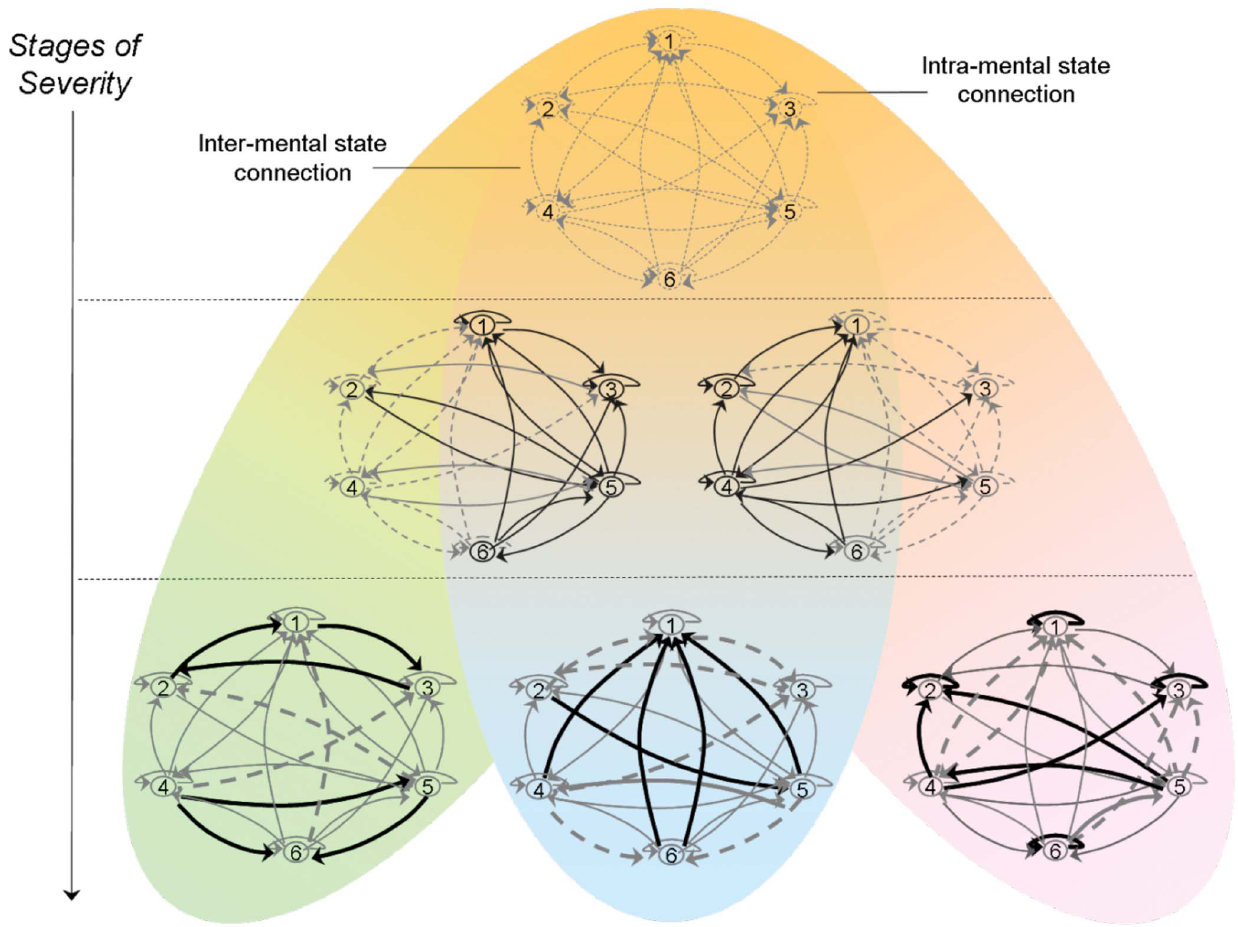
Figure 1. Visual representation of dynamics between mental states with increasing levels of psychopathological severity. Depicted is a hypothesized circuit between 6 mental states across different stages of severity. The connections represent the impact of one mental state at time point t -1 on another mental state at time-point t . The impact of a mental state on itself from t -1 to t is the intra-mental state connection. In the earliest stage, inter and intra-mental state connections are uniformly weak (top; dotted lines). In the next stage, inter- and intra-mental state connections not only get stronger (middle; solid lines), but there are also more differences between persons with regard to which connections get stronger (person on the left strongest connections on the right side of the circuit, person on the right strongest connections on the left side of the circuit), i.e. there is more profiling. In the most severe stage of psychopathology, mental state connections are growing even stronger (bottom; bold/ dotted lines) and more variable across persons. The increased variability in connection strength can be quantified by the random effect from the multilevel random regression model. Thus, staging is represented in this figure by increasing severity of psychopathology, reflected by more powerful connections between mental states impacting on each other, and profiling is represented by the gradual differentiation of syndromes (indicated by different colours) with increasing levels of psychopathological severity. Based on: Epskamp, S., Cramer, A. O. J., Waldorp, L. J., Schmittmann, V. D. & Borsboom, D. (2012). Qgraph: Network visualizations of relationships in psychometric data. Journal of Statistical Software, 48,